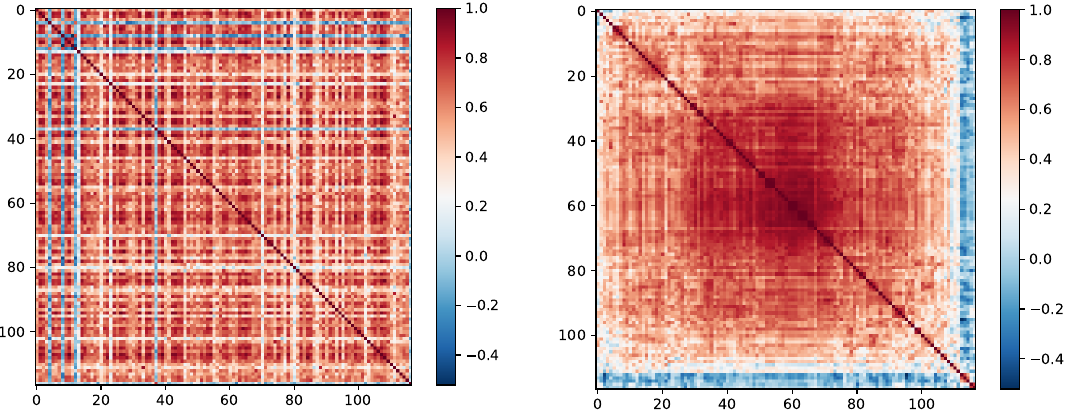
Figure 3. Original correlation distance matrix ( left ) and after matrix seriation or quasi-diagonalization ( right